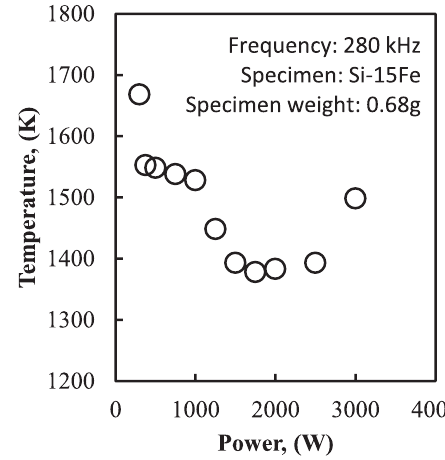
Fig. 10: Effect of applied power on the steady state temperature of silicon-iron alloy droplet